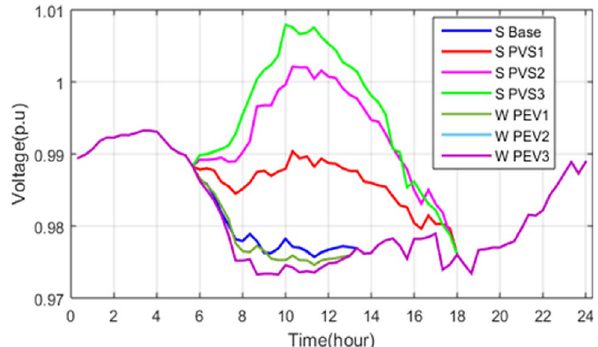
Figure 24. Analysis of daily pro fi les of voltage in summer as well as winter.